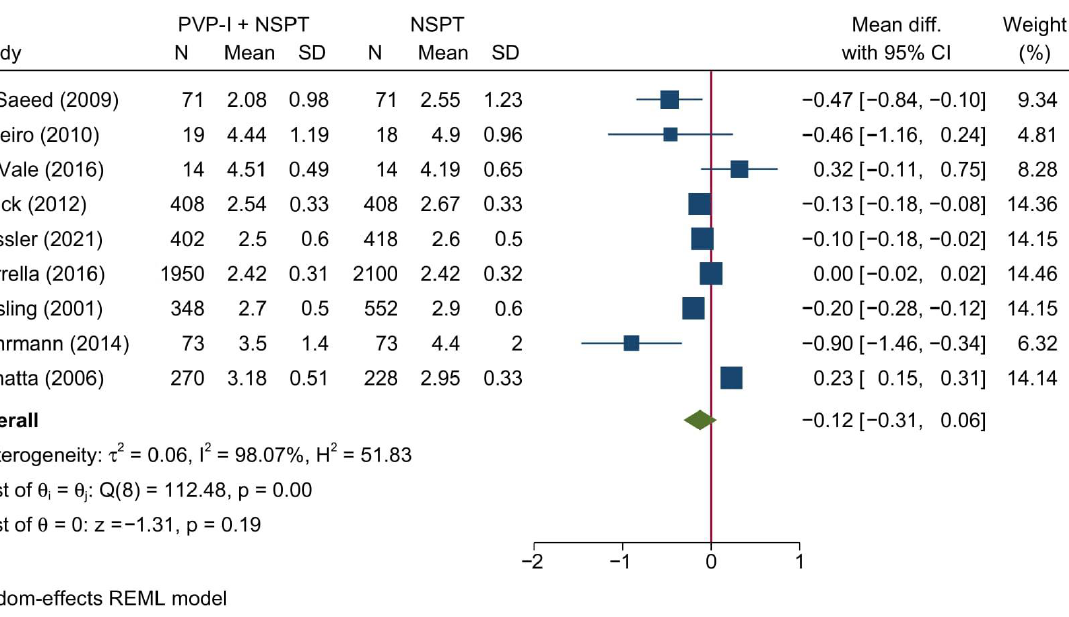
Figure 2. Forest plot showing the comparison between PVP-I + NSPT and NSPT alone regarding probing pocket depth [30,34,38,40,42–44,46,47].